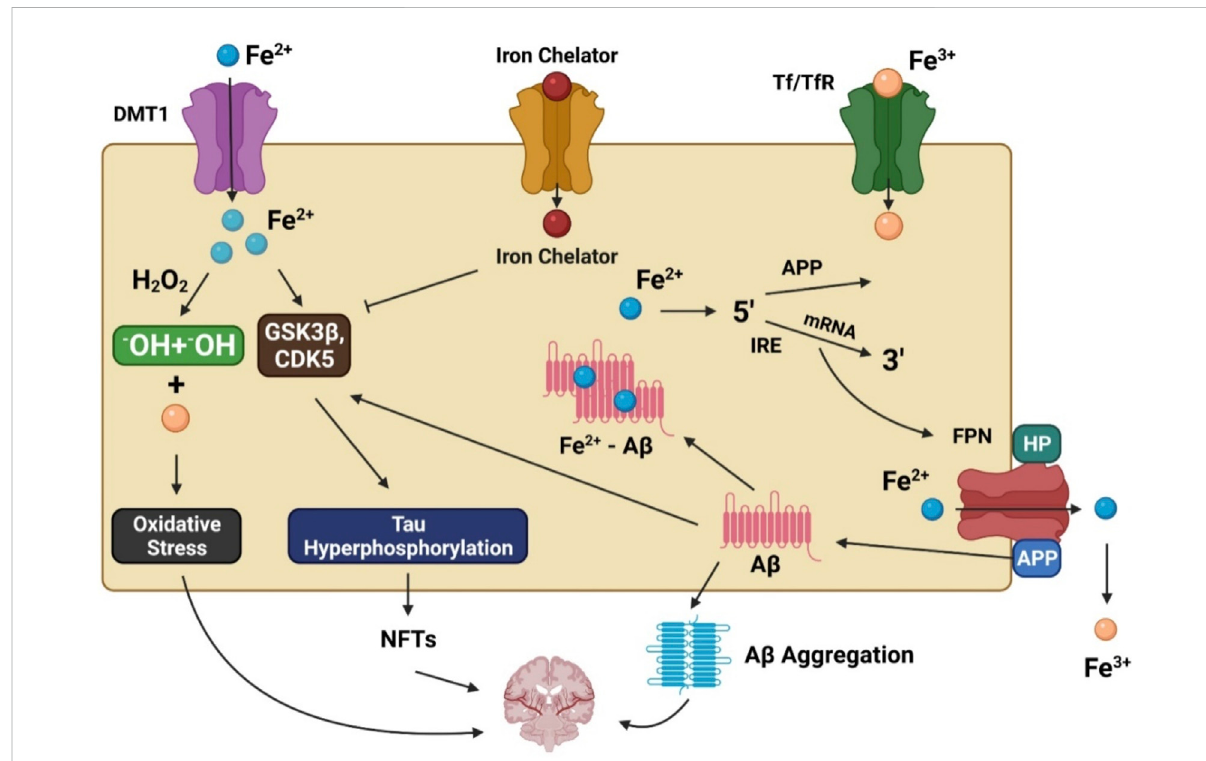
The involvement of iron in Alzheimer ’ s disease pathogenesis. DMT1 allows ferrous iron (Fe 2+ ) to pass through the cell directly, while transferrin (Tf)-ferric iron (Fe 3+ ) penetrates via endocytosis mediated by the transferrin receptor (TfR). Increased Fe 2+ levels trigger the Fenton reaction, which (cid:129) OH), resulting in oxidative stress and neurotoxicity. Moreover, Fe 2+ can increase tau phosphorylation by activating produces the hydroxyl radical ( glycogen synthase kinase 3 β (GSK3 β ) and cyclin-dependent kinase 5 (CDK5), resulting in neuro fi brillary tangle development (NFTs). GSK3 and CDK5 are inhibited by iron chelators, which diminish tau phosphorylation. Fe2+ interacts to the iron responsive element (IRE) in the 5 ′ UTR area of amyloid precursor protein (APP) mRNA in the biological environment, resulting in the stimulation of APP translation and the production of amyloid beta (A β